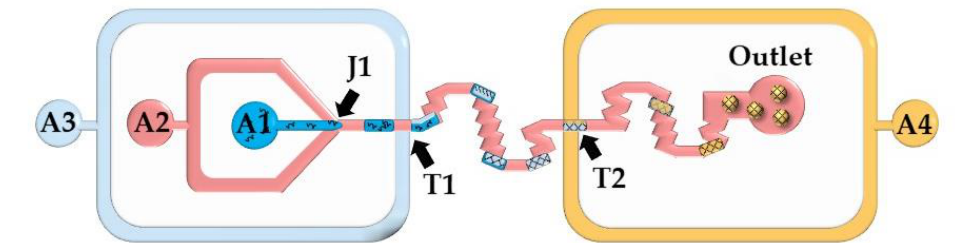
Figure 13. Detection of glucose in a microfluidic chip using calcium alginate beads containing glucose oxidase, horseradish peroxidase, and Amplex® Red. The chip consists of one Ψ junction (J1) used for alginate droplet generation, and two double T-junctions used for injection of CaCl 2 solution (T1) and glucose solution (T2) from the inlets A3 and A4, respectively [63].